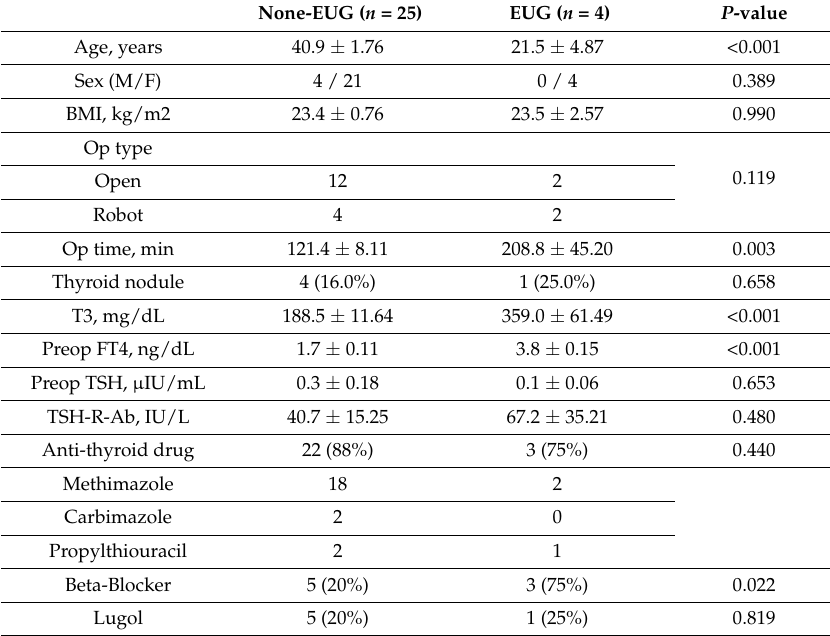
Table 3. Demographic and clinical characteristics of patients with extremely uncontrolled and non-extremely uncontrolled Graves’